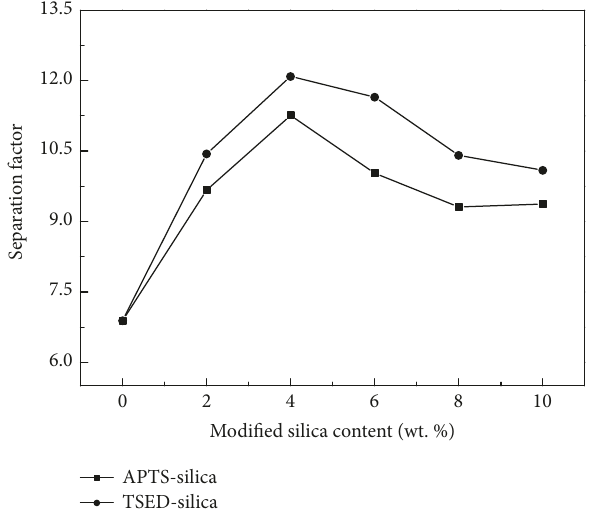
Figure 8: Effect of modified fumed silica content on separation